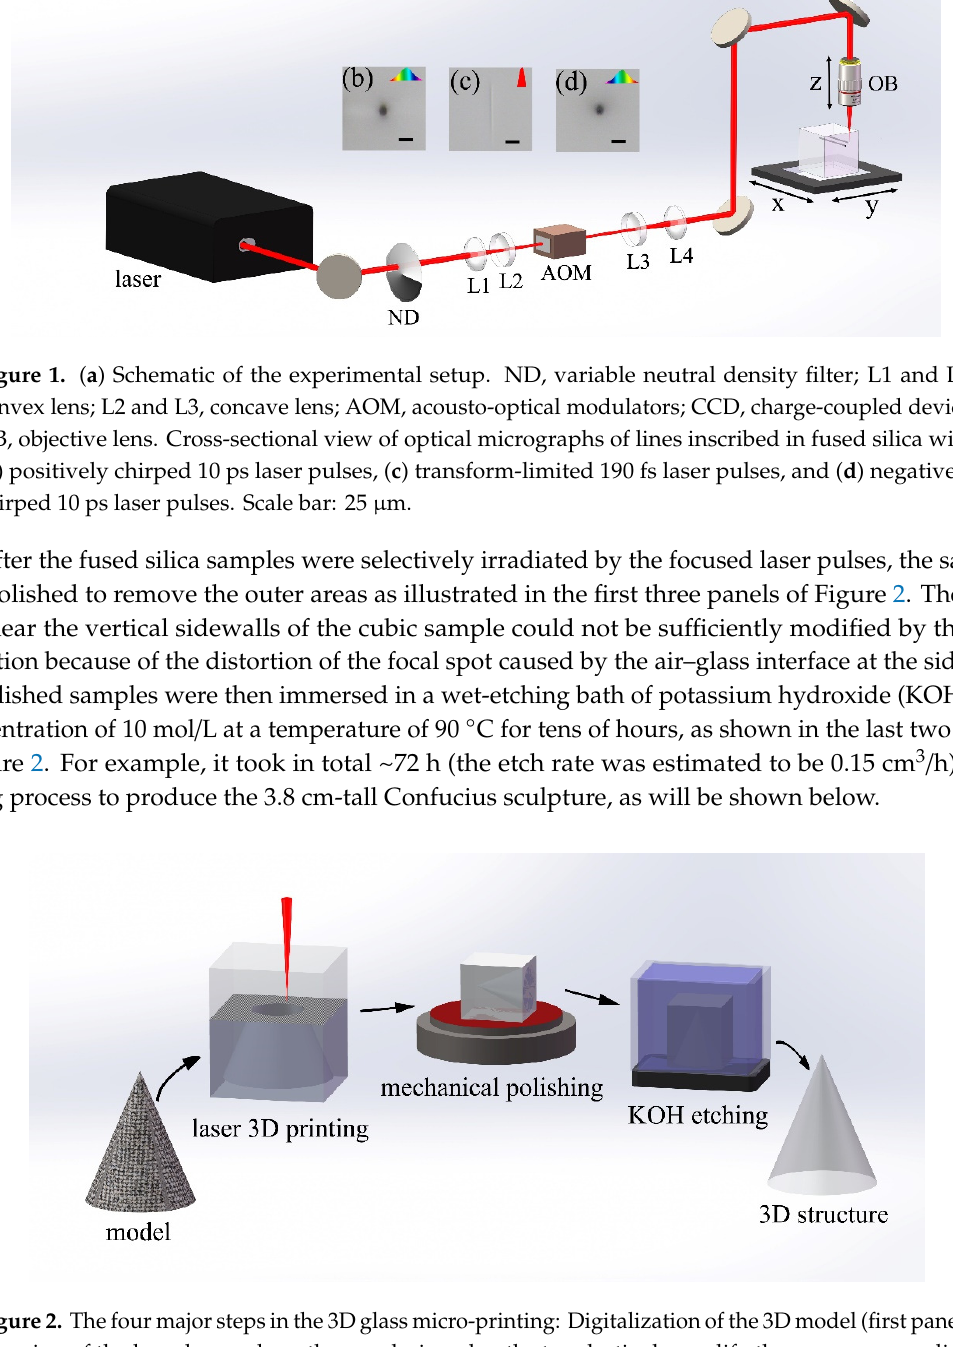
Figure 2. The four major steps in the 3D glass micro-printing: Digitalization of the 3D model (first panel), scanning of the laser beam along the pre-designed paths to selectively modify the areas surrounding the 3D objects (second panel), mechanical polishing (third panel), removal of the irradiated materials with chemical wet etching (fourth panel). The printed 3D structure is illustrated in the last panel.